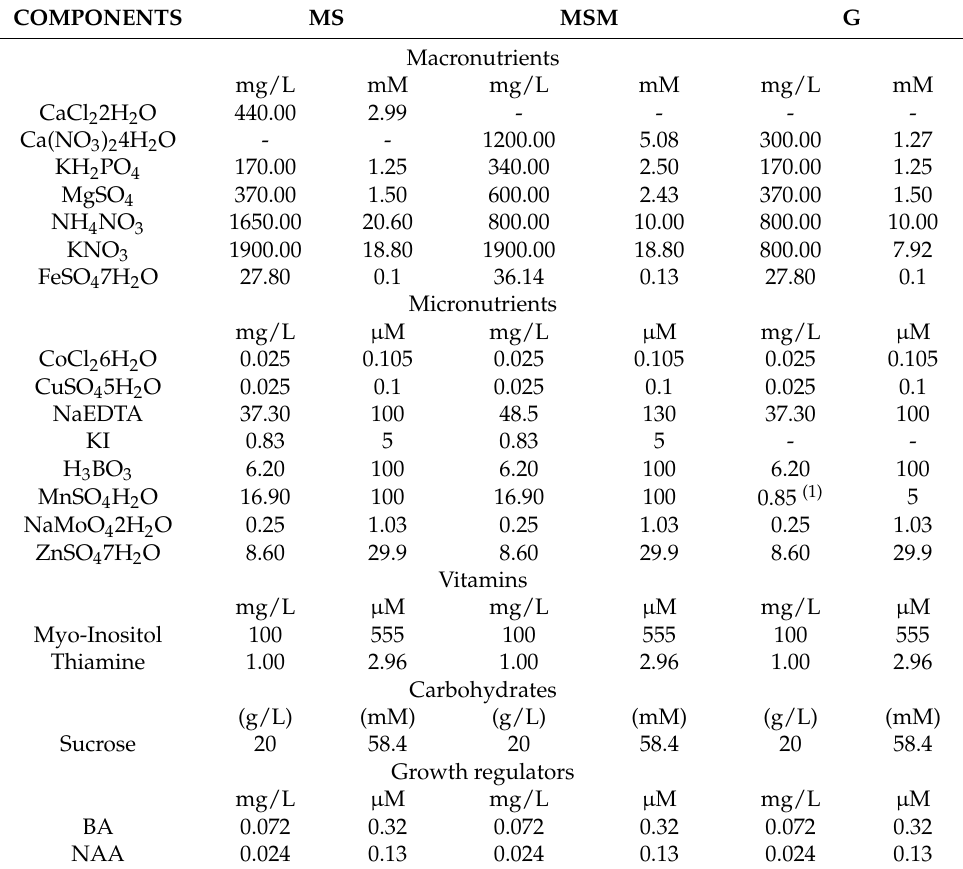
Table 4. Basal composition of the substrates used.